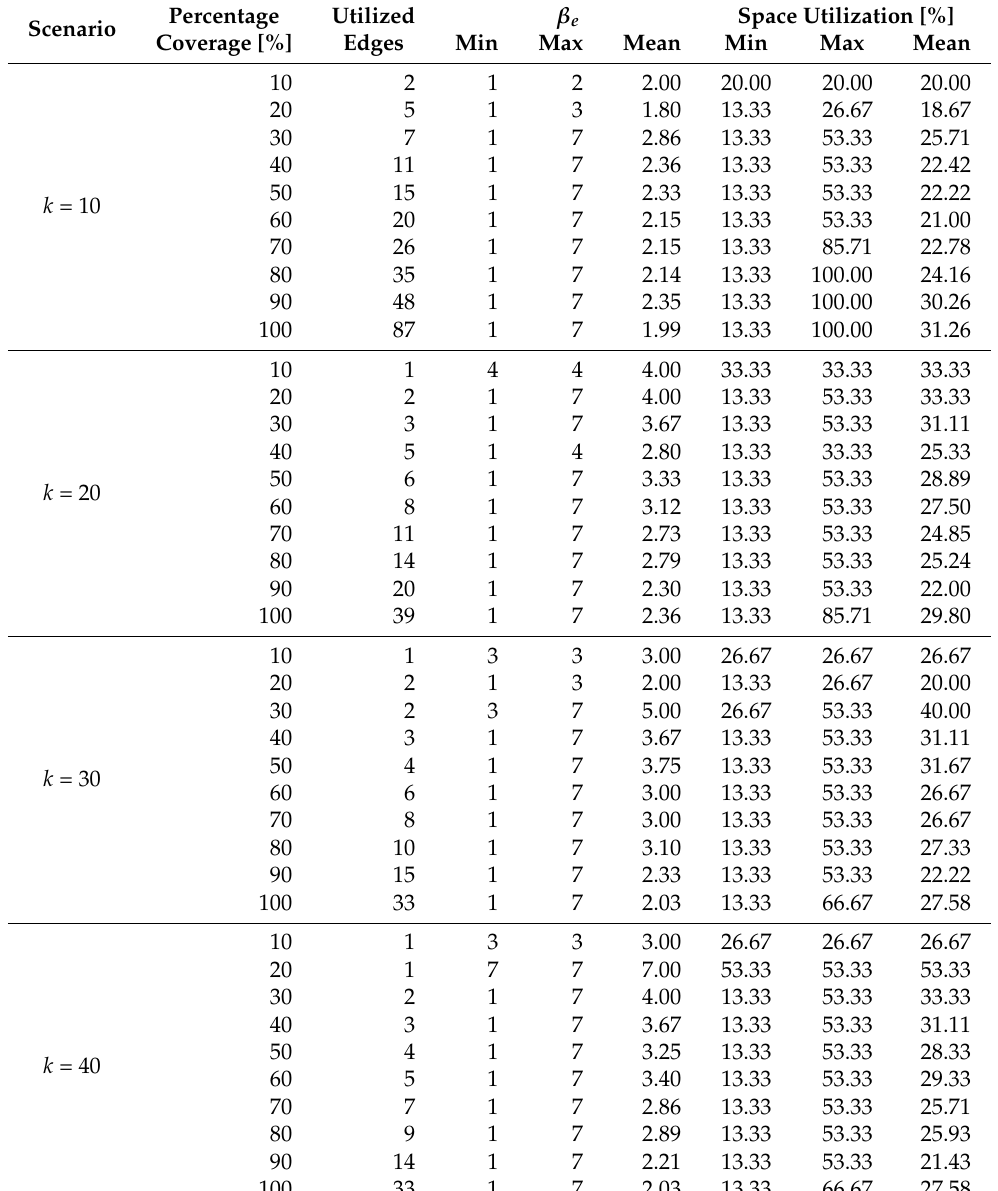
Table A2. Aggregated statistics of space utilization in the edges of dataset 2 test